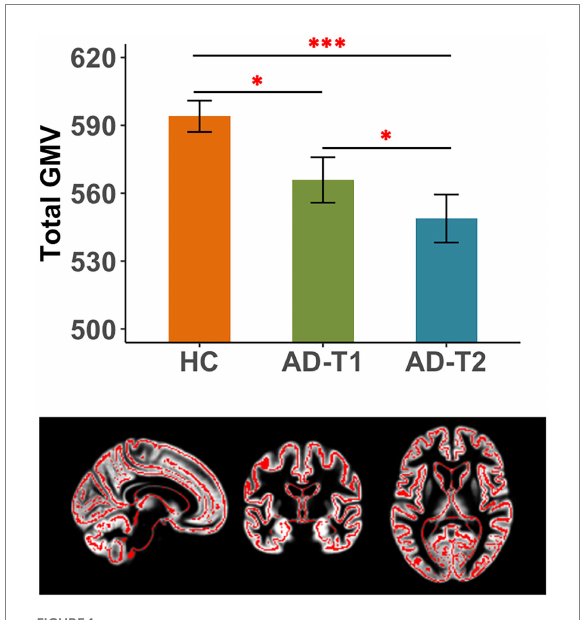
FIGURE 1 Reduced total grey matter volume (GMV) in AD patients. There were significant differences in total GMV between HC and AD-T1, between HC and AD-T2, and between AD-T1 and AD-T2. * p < 0.05, *** p <